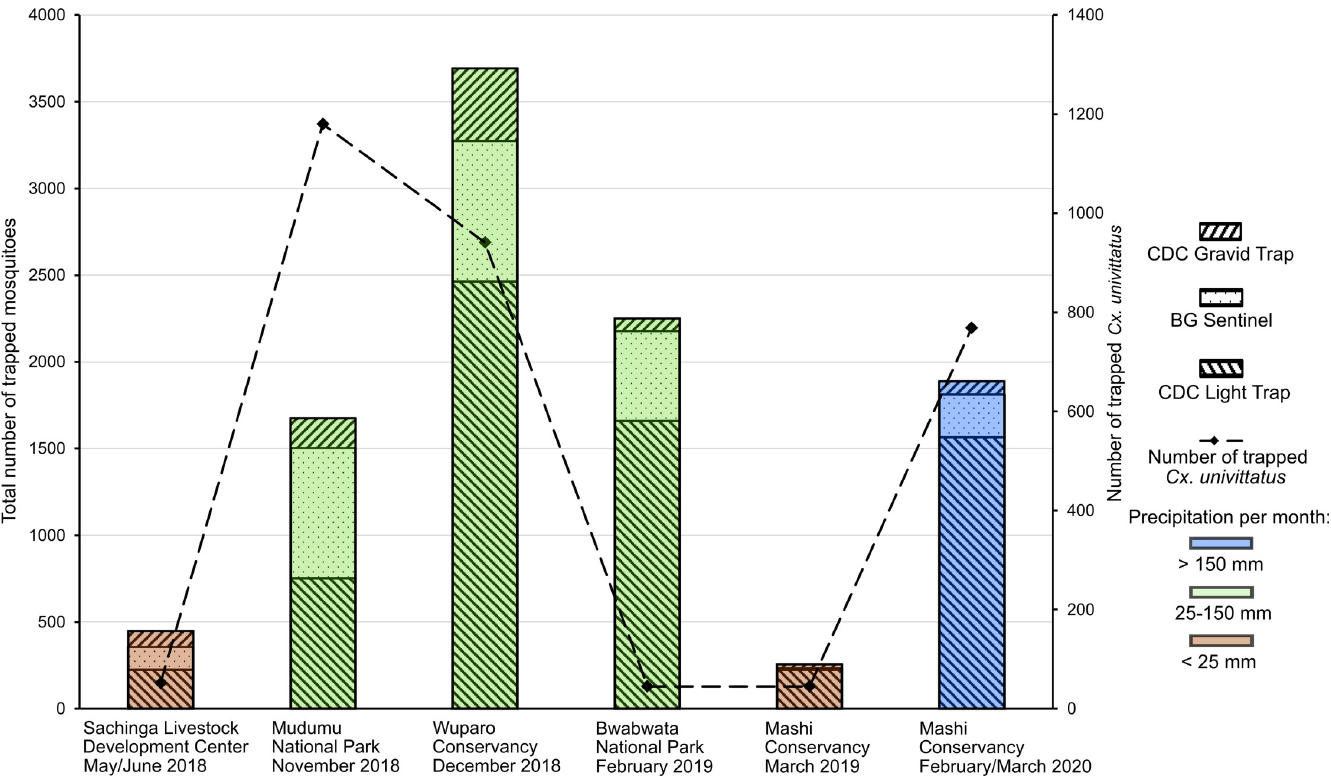
Fig 2. Overview of collected mosquitoes in the Zambezi region, Namibia. Number of sampled mosquitoes per locality and collection time is given by bar charts according to trap type and amount of rainfall at the time of collection [69]. Number of collected Cx . univittatus mosquitoes per locality is shown by a dashed line.